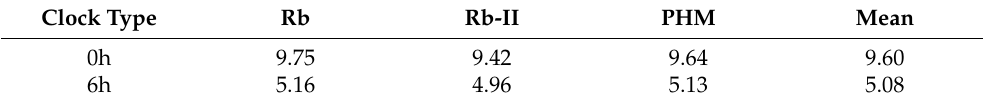
Table 9. The statistics of the average RMS values of initial residuals in different clock bias files.